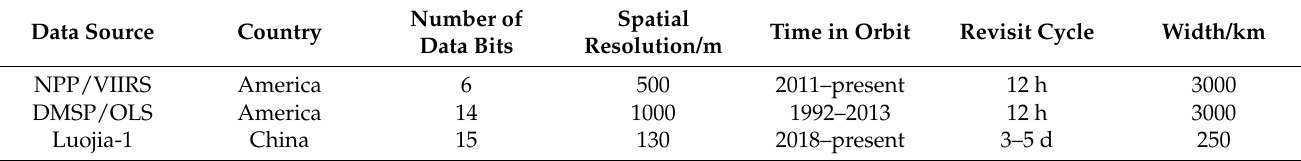
Table 1. Comparison of different nighttime light data parameters.